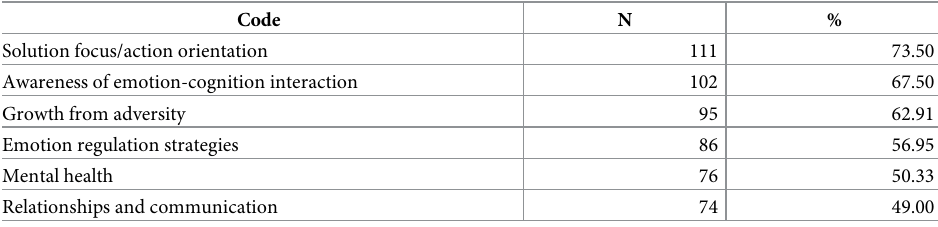
Table 3. Thematic analysis